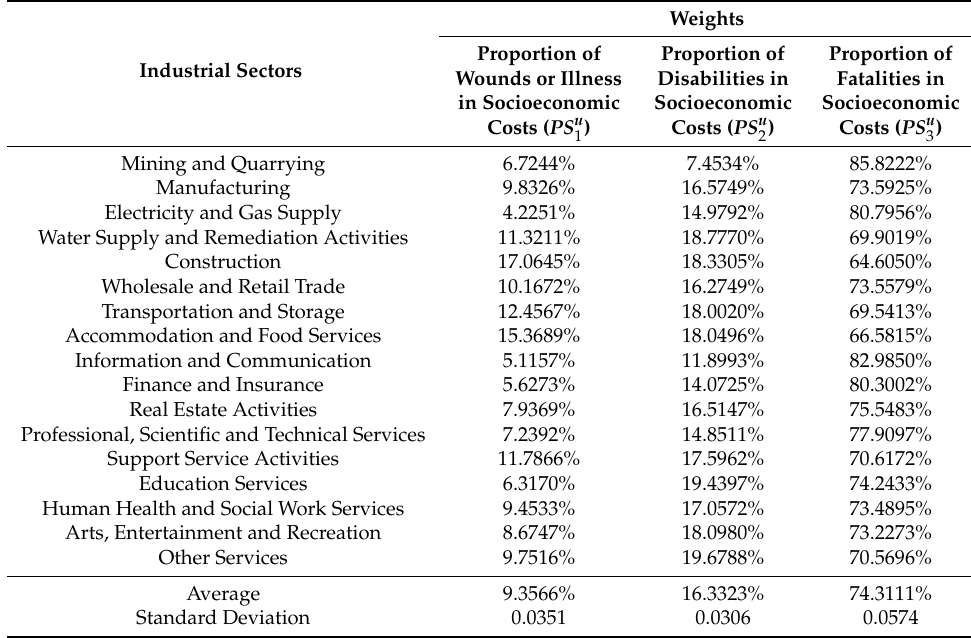
Table 2. Proportions of the socioeconomic costs of occupational accidents by industrial